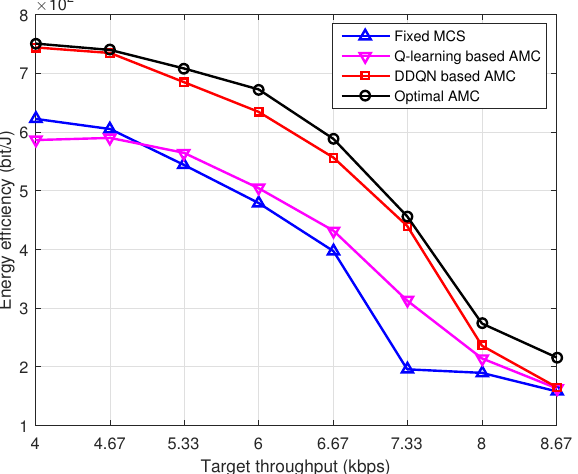
Figure 13. The channel state transition probability with (cid:101) = 0.5.